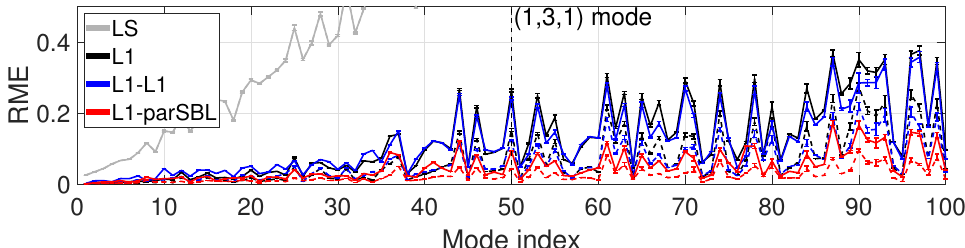
Figure 3. (Color online) Relative mean error (RME) of different methods in different modes (—: R = 400; - -: R = 1000